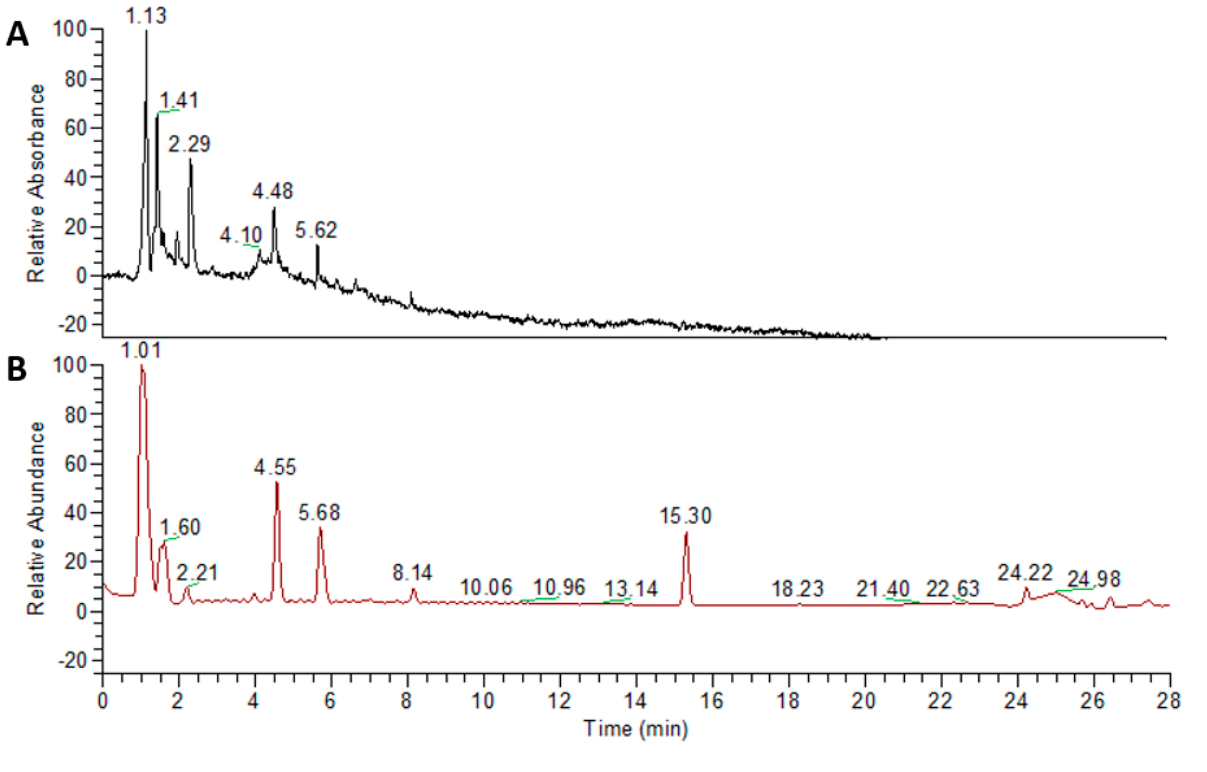
Figure 7. Fingerprinting analysis of YJT using ultra–high–performance liquid chromatography (UHPLC). To elucidate the chemical compositions of YJT, fingerprinting analysis was performed using Accela ultra–high–performance liquid chromatography (UPLC–MS/MS) with two different modes: ( A ) PDA and ( B ) MS+ modes,